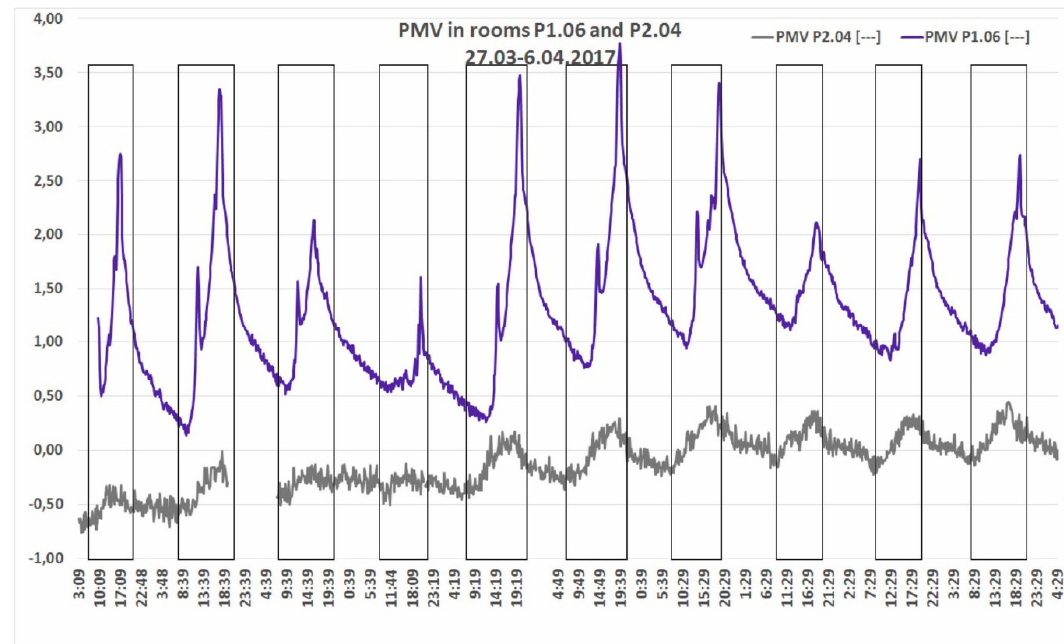
Figure 15. Values of predicted mean vote (PMV) index in rooms P1.06 and P2.04. Visible data gaps are caused by technical problems with the measuring equipment. The sensors had to be submitted for technical inspection.